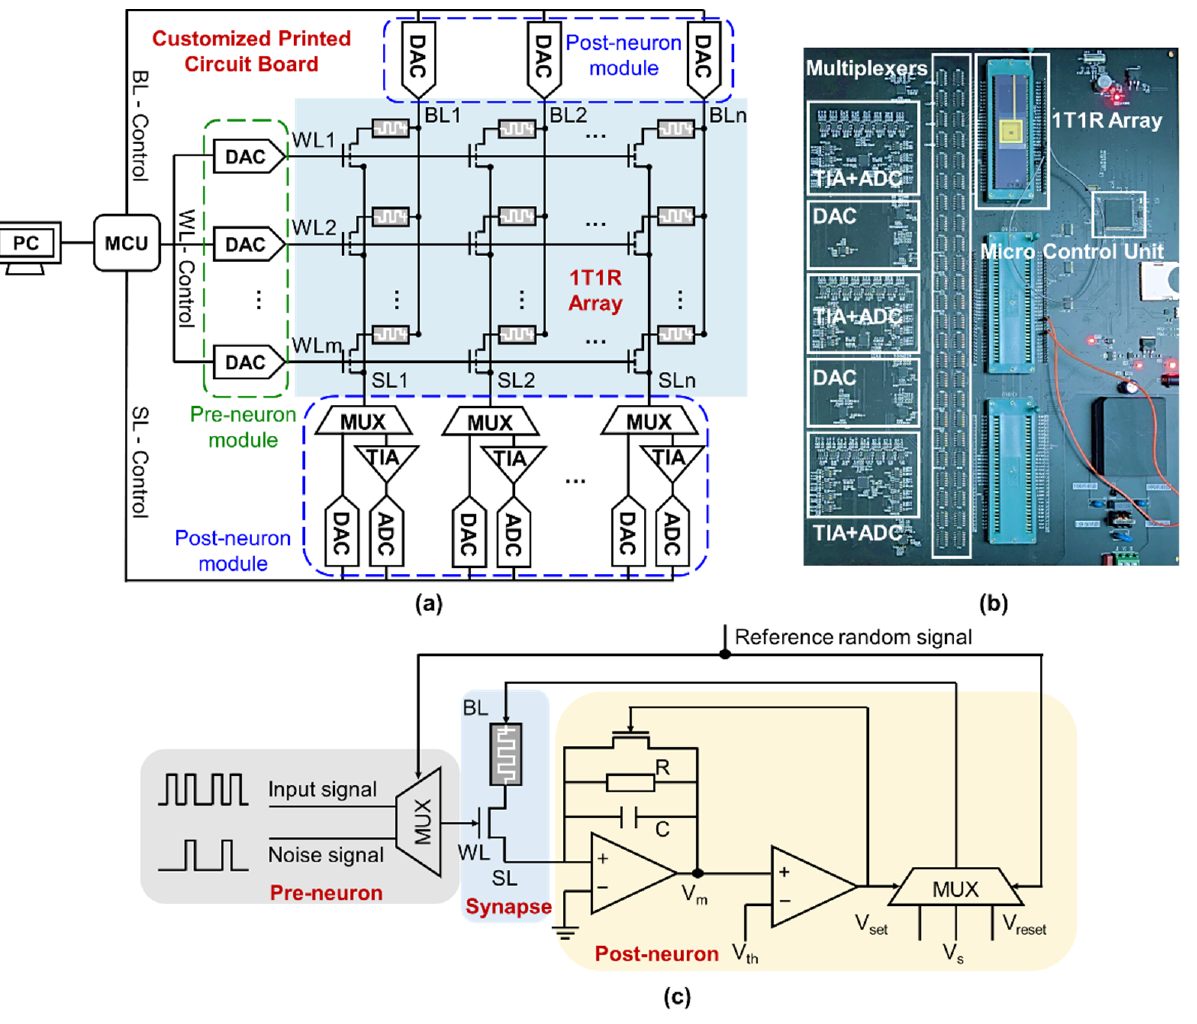
Figure 1. Memristor-based neuromorphic system. ( a ) Circuit diagram of the system; ( b ) Photograph of the customized printed circuit board; ( c ) Circuit diagram of the memristor synapse and the corresponding CMOS neurons.